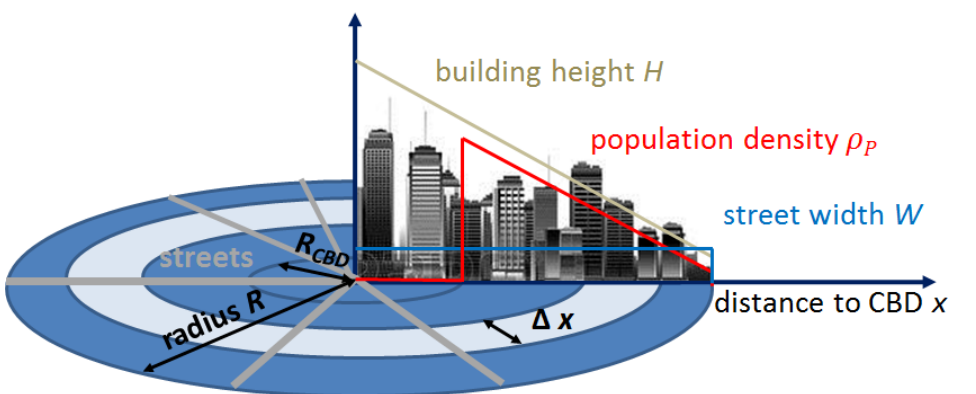
Figure 2. Schematic graphic of the simplified city and its properties.